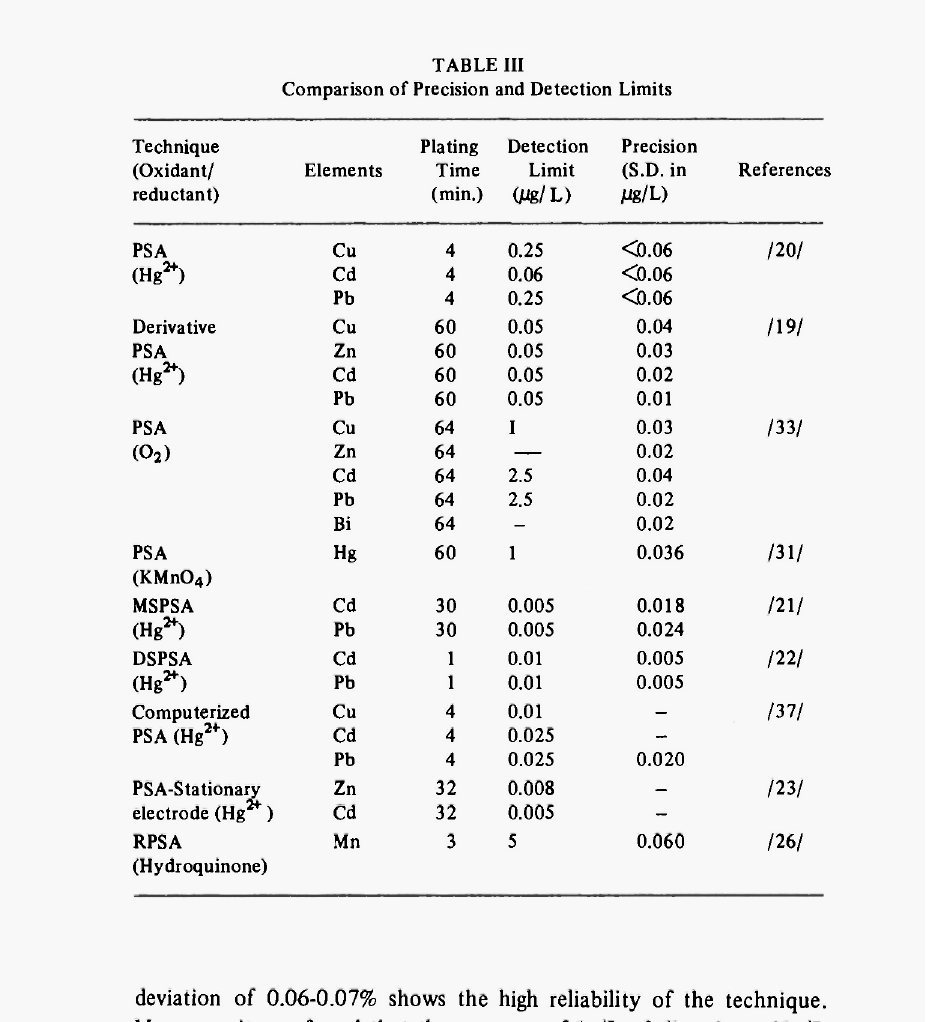
TABLE III Comparison of Precision and Detection